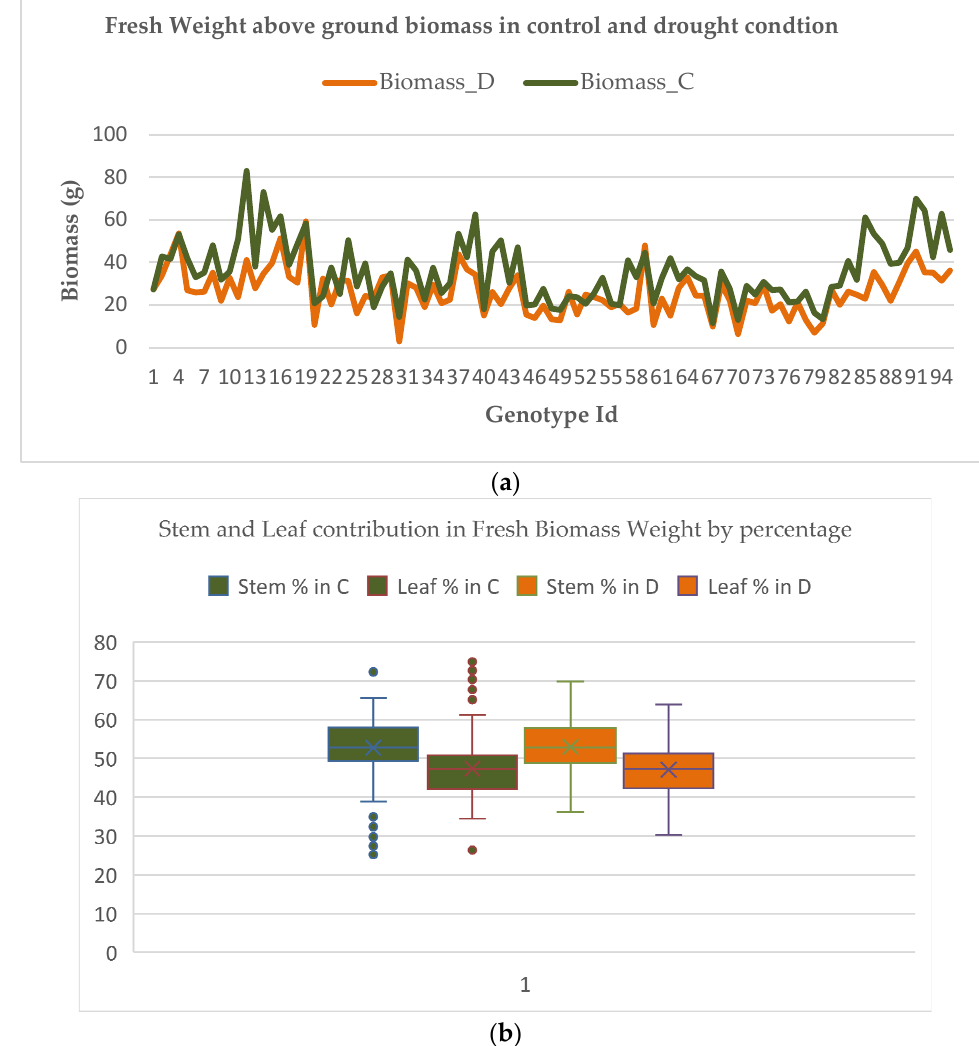
Figure 7. ( a ) Comparison of biomass (fresh weight) of the genotypes in drought and control condi- tions, and ( b ) stem and leaf contribution by percentage in biomass, for fresh weight.